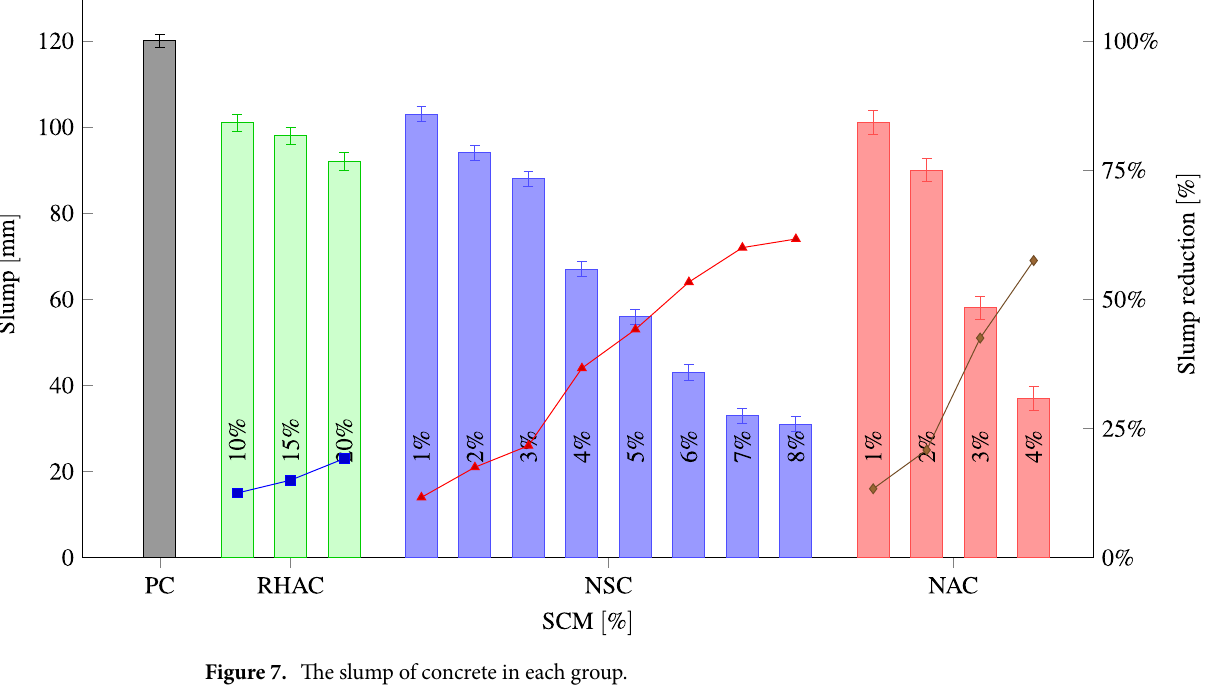
Figure 7. The slump of concrete in each